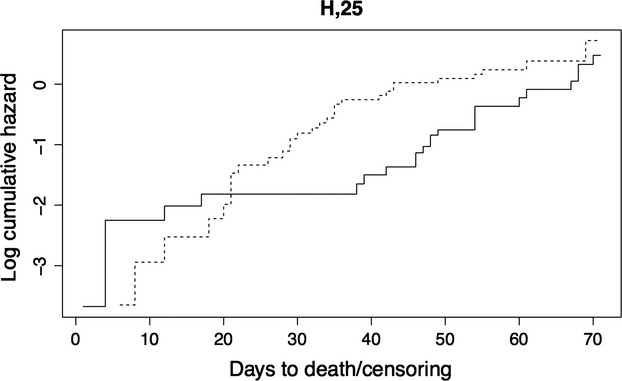
Hazard curves of females from line H, 25 after experiencing homotypic (solid line) or heterotypic (dashed line) matings.